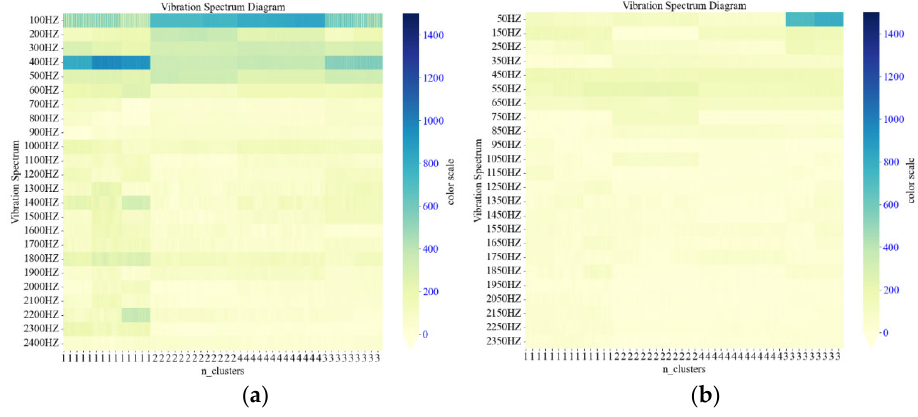
Figure 9. Vibration spectrum clustering heat map: ( a ) Even times; ( b ) Odd times.